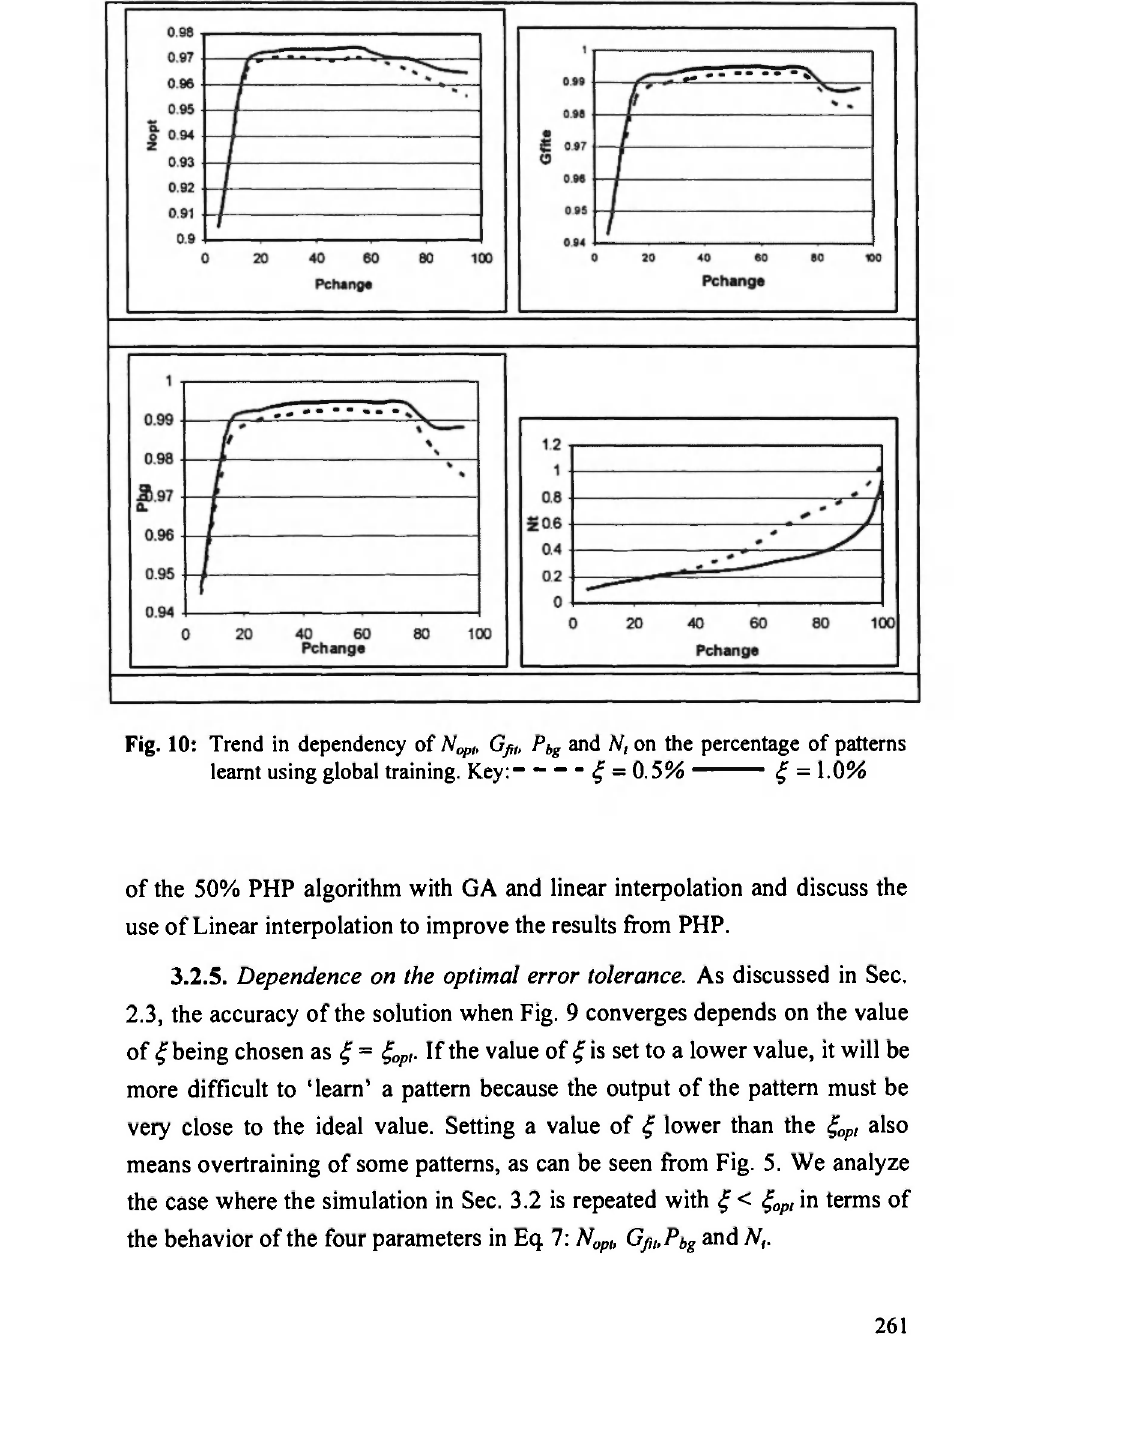
of the 50% PHP algorithm with GA and linear interpolation and discuss the use of Linear interpolation to improve the results from